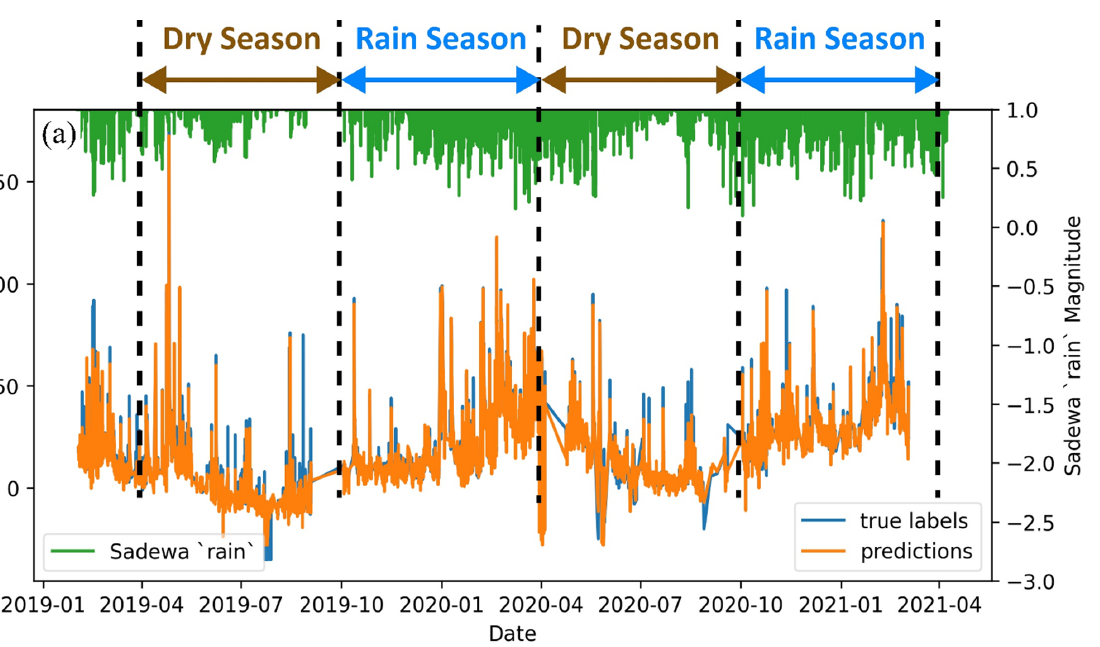
Figure 7. ( a ) Timeseries comparison between true labels (Katulampa water record levels, blue line) and LSTM RNN-predicted water level (orange line), with Sadewa’s rainfall value as an added in- formation; scatterplot comparing predicted data vs. true labels for ( b ) training and ( c ) testing da- tasets. Figure 8 shows that the model could maintain an R² performance of more than 0.85 for the next 12 h. With a predictable decrease for the next 24 h, the model can still explain 80% of the discharge events. This R² decrease occurs at a rate of 0.0018 for every 1-h incre- ment of the forward time domain. Prior studies [18,48] discussed such behavior, discuss- ing that as the system tries to predict further into the future, the system then becomes more complex, and it is progressively more expensive to make an accurate prediction.